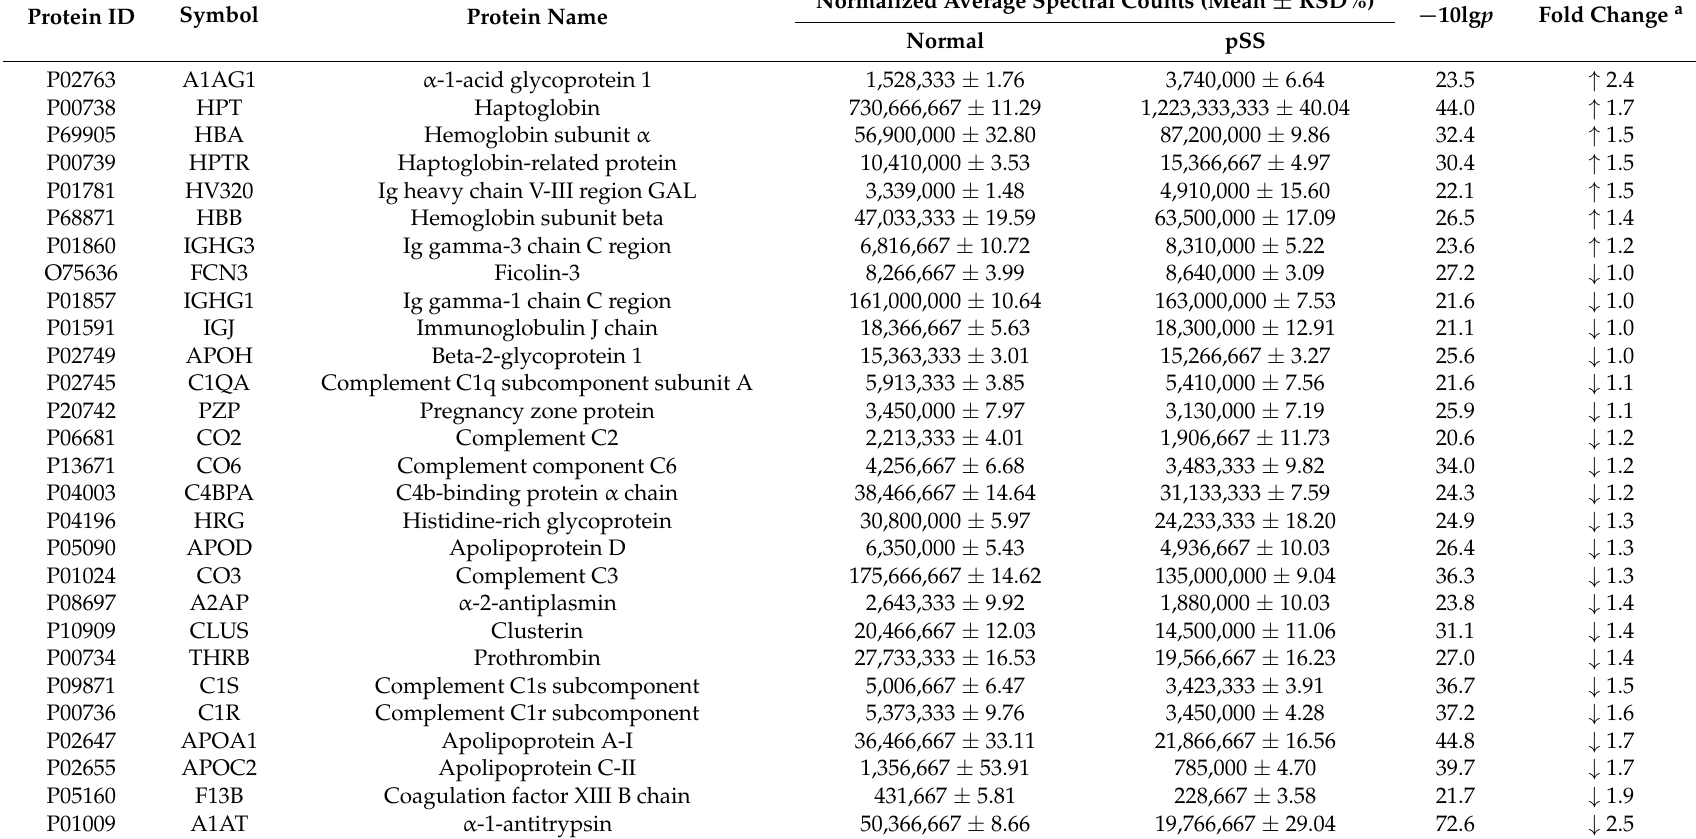
Table 1. Differentially expressed serum proteins identified by in-solution digestion and LC-MS/MS analysis in patients with primary Sjögren’s syndrome (pSS) and healthy controls